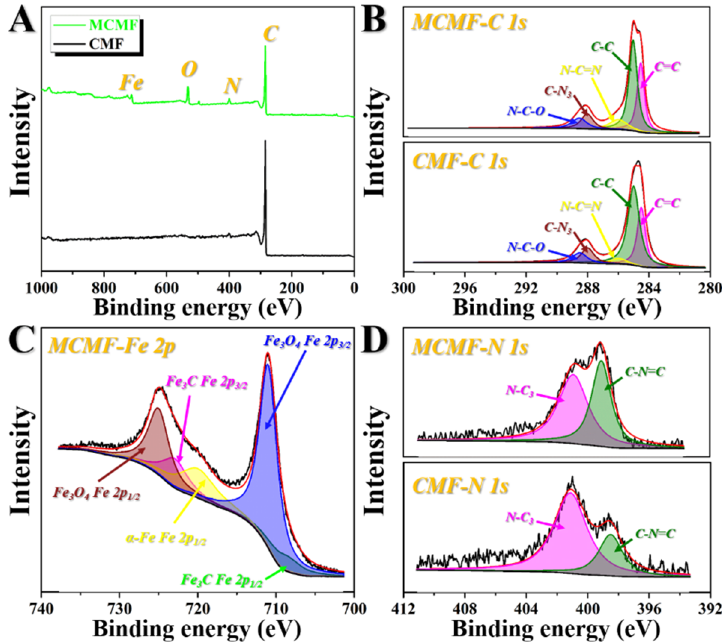
Figure 3. XPS spectra of CMF and MCMF ( A ) along with corresponding high-resolution XPS spectra of C1s, Fe2p and N1s ( B – D ), respectively.